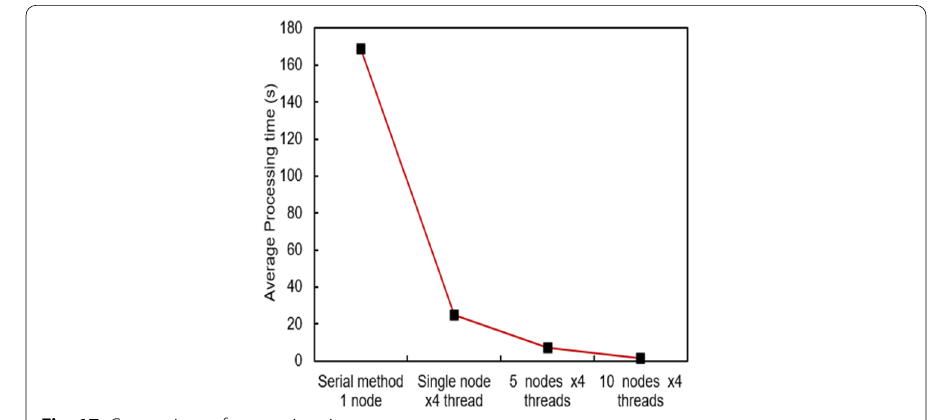
Fig. 17 Comparison of processing time